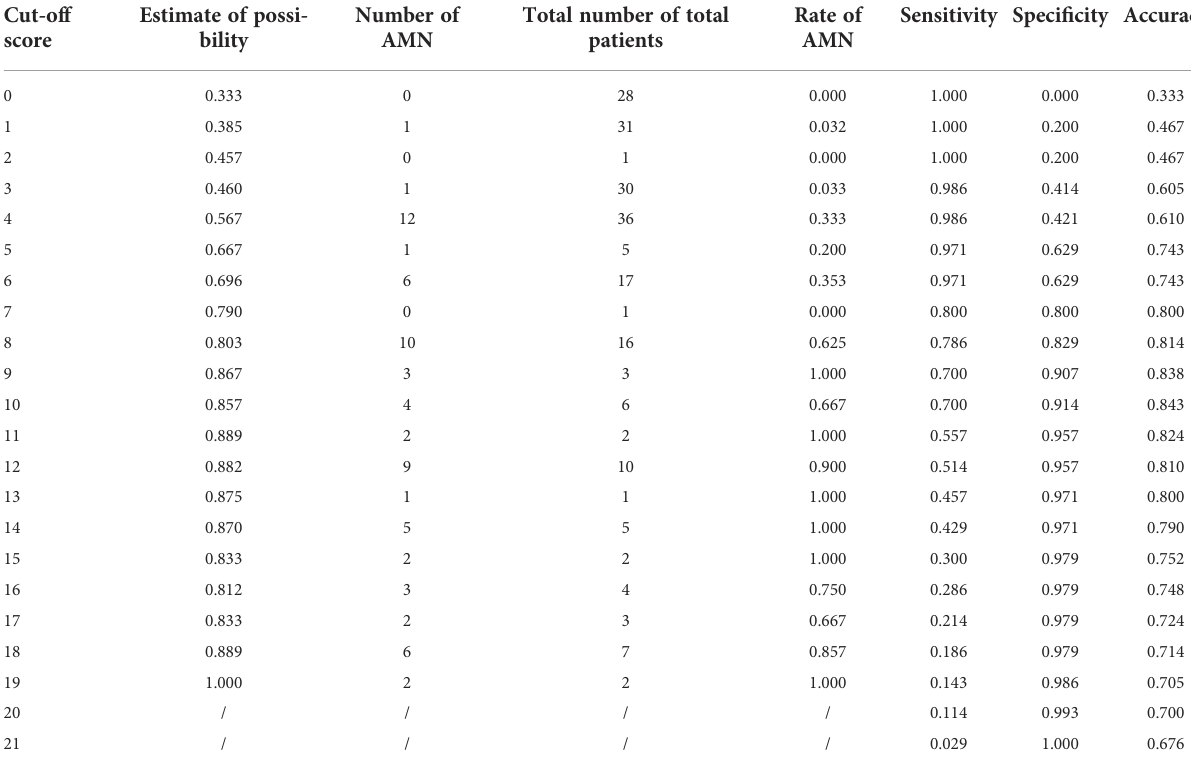
TABLE 5 Presentation of different cut-off scores.